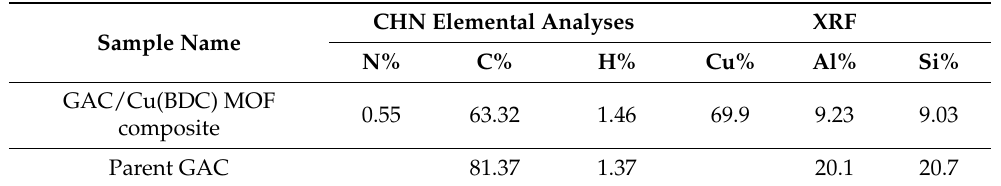
Table 1. Elemental composition of parent GAC and GAC /Cu (BDC) MOF composite. Reported by CHNS elemental analysis and XRF